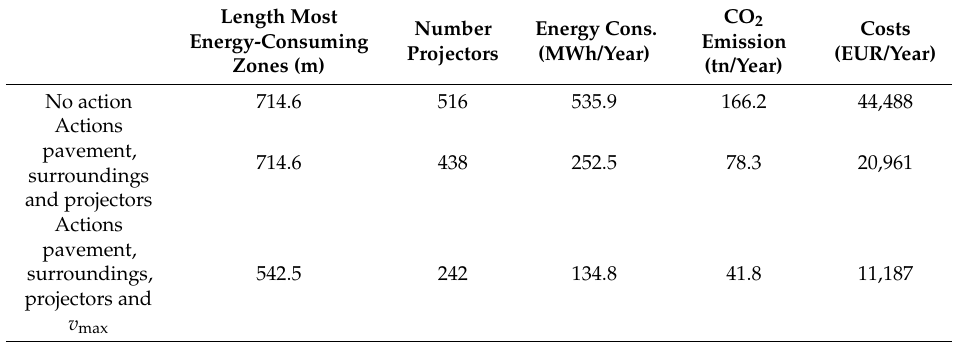
Table 6. Comparison of lighting installation parameters with no action, actions on pavement, portal surroundings and LED projectors, and these actions combined with maximum speed reduction and